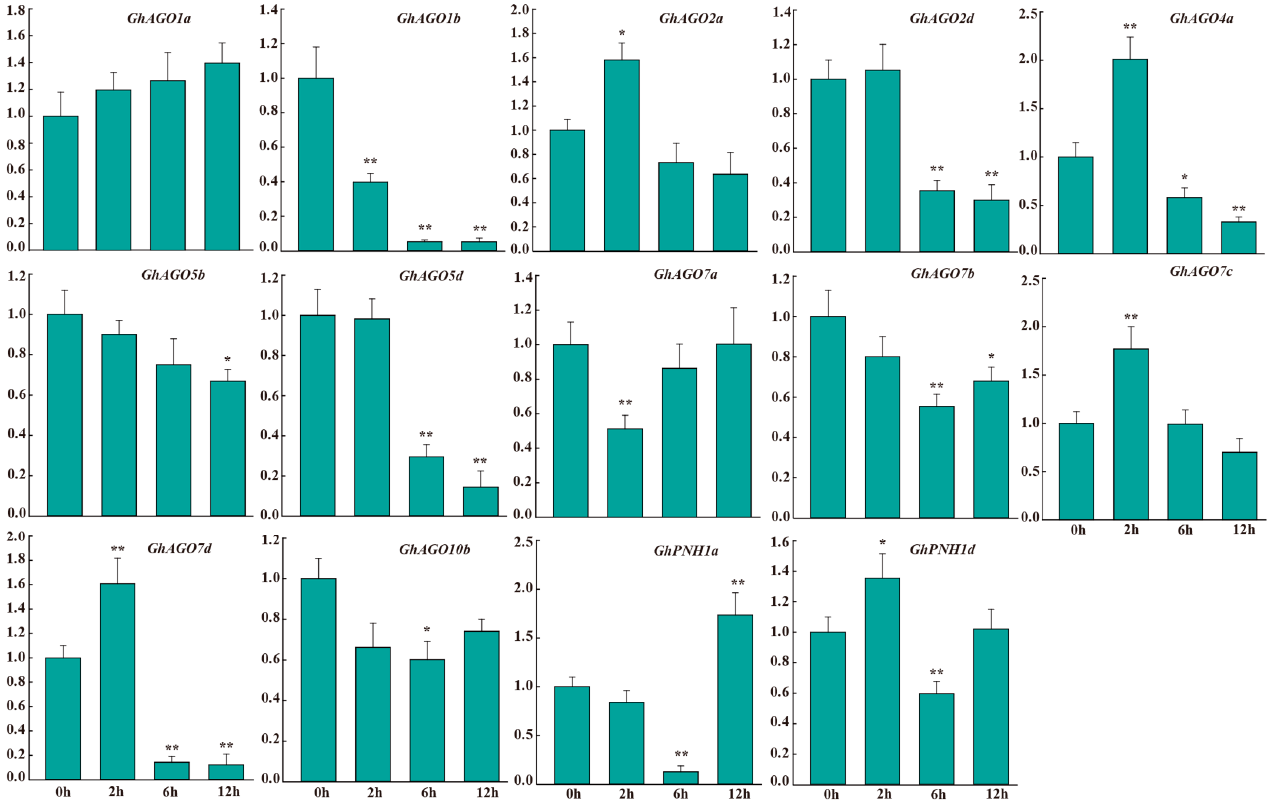
Figure 7. Expression analyses of the GhAGO genes in roots under Verticillium wilt infection. qPCR was used to determine the expression profiles of 14 GhAGO genes under Verticillium wilt infection. The standard deviation is indicated by the error bars, and “*” (Tukey’s HSD, p ≤ 0.05) and “**” ( p ≤ 0.01) indicate significant differences between the treatment and control.